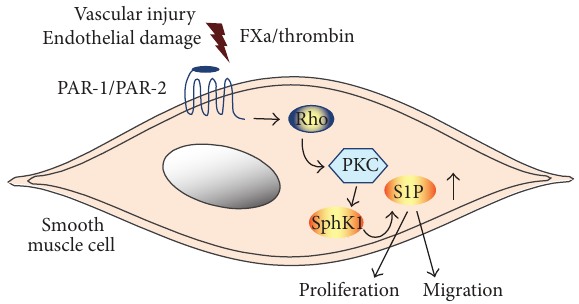
Figure 3: The coagulation proteases thrombin and activated factor X (FXa) enhance S1P synthesis and release from vascular smooth muscle cells (VSCMs). During vascular injury, local generation of thrombin and FXa enhances the synthesis and the release of S1P via activation of PAR-1 and PAR-2, respectively. This signaling pathway involves activation of the small GTPase Rho and PKC signaling leading to transcriptional upregulation of SphK-1. The resulting S1P activities regulate proliferation and migration of